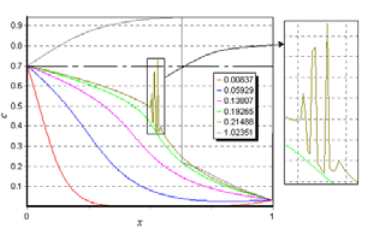
Figure(cid:0)(cid:1)Thedistributionofcon(cid:13)